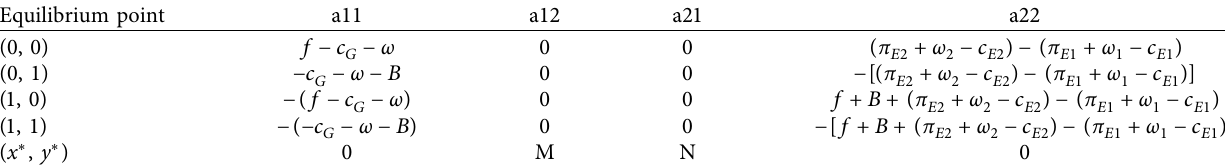
Table 3: Parameter value at the equilibrium point.